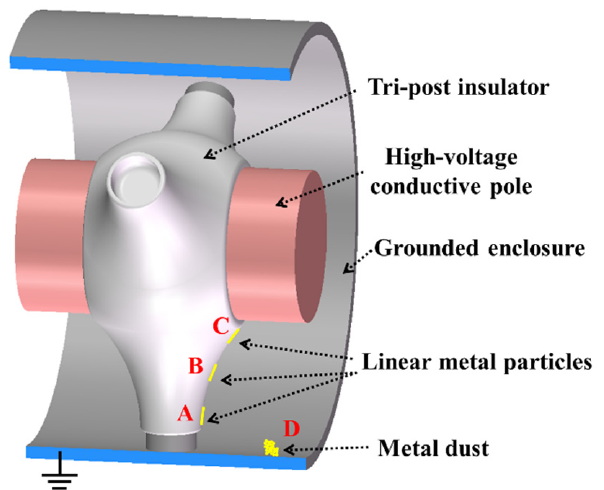
Figure 2. Locations of metal contaminants.